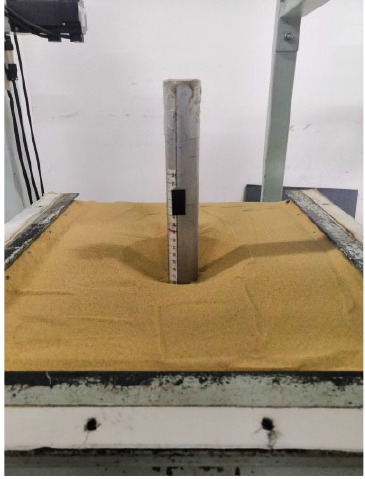
Figure 7. Photographs of a scour hole 𝑠 (cid:3031) = 1D.